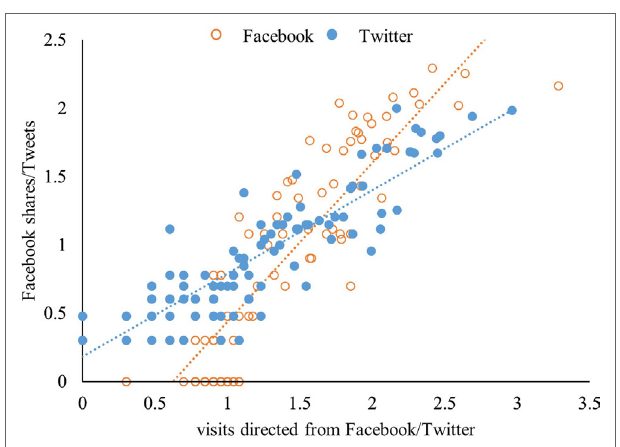
FigUre 3 | Scatter plot of social media attention and caused visits (Log